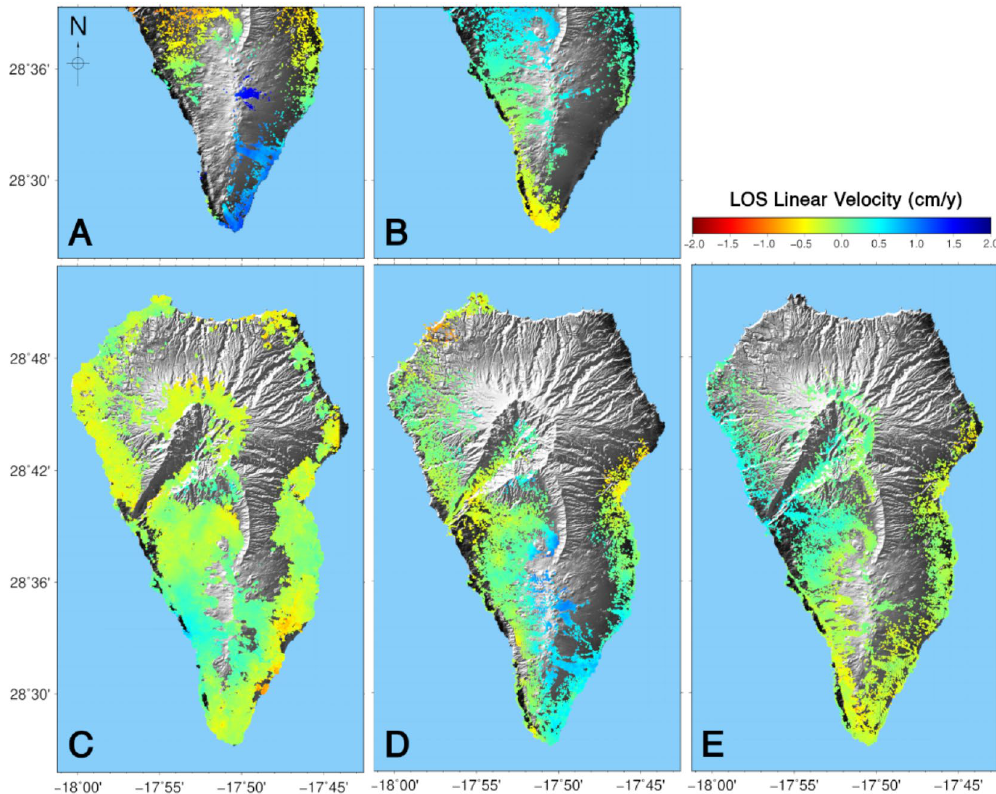
Figure 2. Annual mean LOS velocities obtained for the La Palma Island. ( A ) For the period 2006–2010 results obtained with SAR images from the ENVISAT satellite acquired in ascending orbits; ( B ) same for images acquired in descending orbits. ( C ) Results obtained using images from RADARSAT-2 satellite acquired in descending orbits for the period 2010–2017. Results for 2017–2020, using Sentinel-1 images: ( D ) acquired in ascending orbits; and ( E ) in descending orbits. GMT software (www.gener ic-mapin g-tools .org) was used to create this